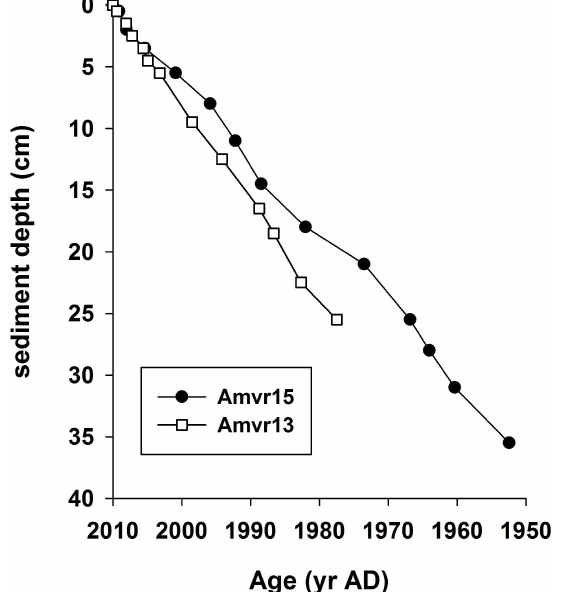
Fig. 2. Age models of cores Amvr15 and Amvr13 based on the specific activity of 210 Pb in the sediment.